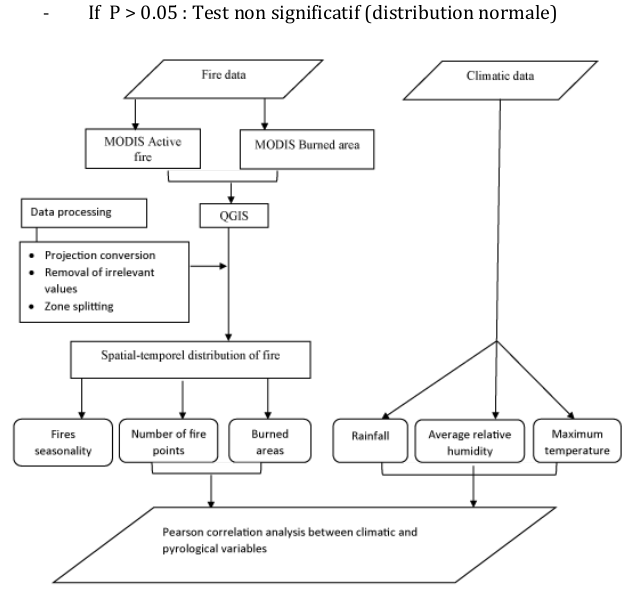
Figure 2: Flowchart of the method